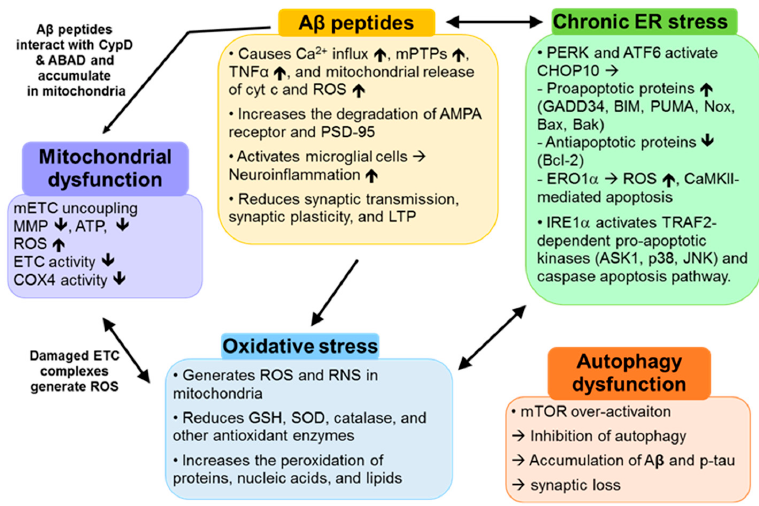
Figure 1. Multifaceted Alzheimer’s Disease (AD) pathogenesis. A β peptides increase calcium influx,